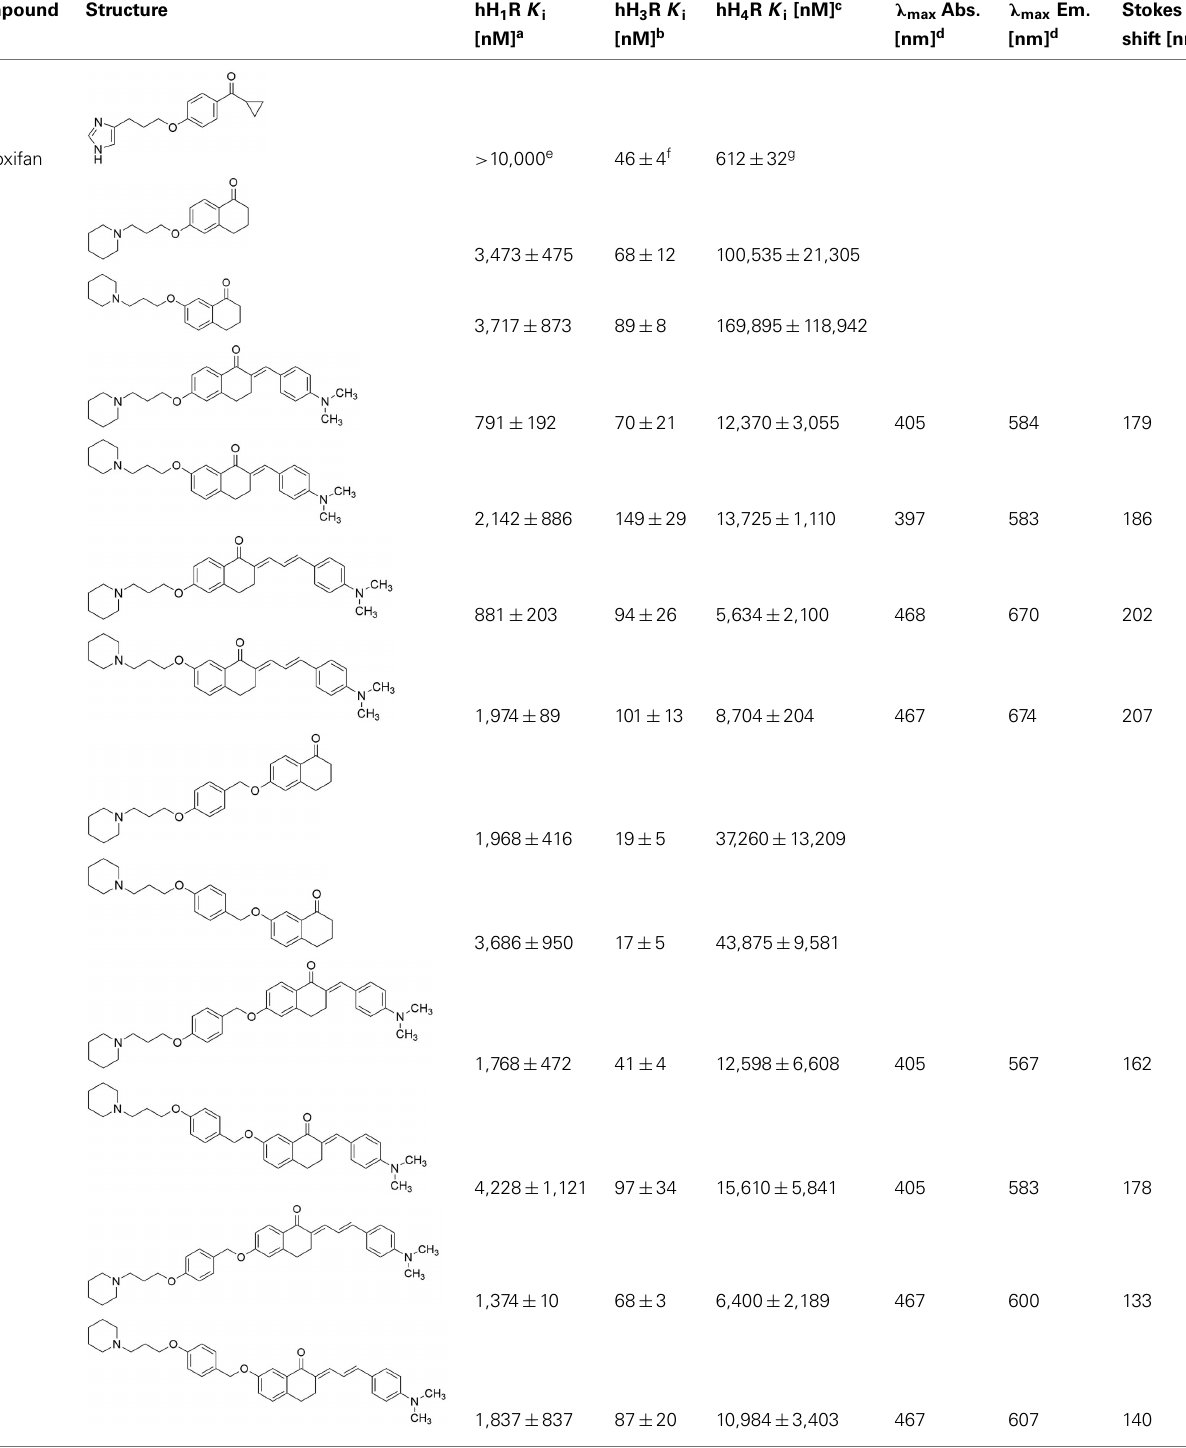
Table 1 | Human histamine H 1 , H 3 , and H 4 receptor affinities and fluorescence absorption and emission maximum wavelengths of novel non-imidazole